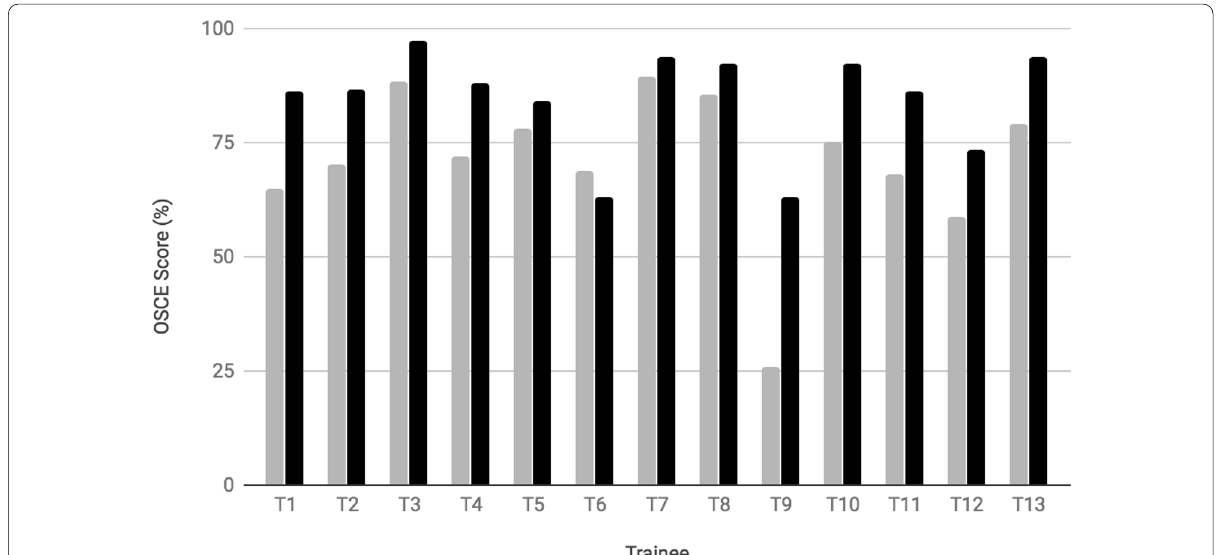
Fig. 1 Individual OSCE scores at the mid-course evaluation (gray) and final course evaluation (black)